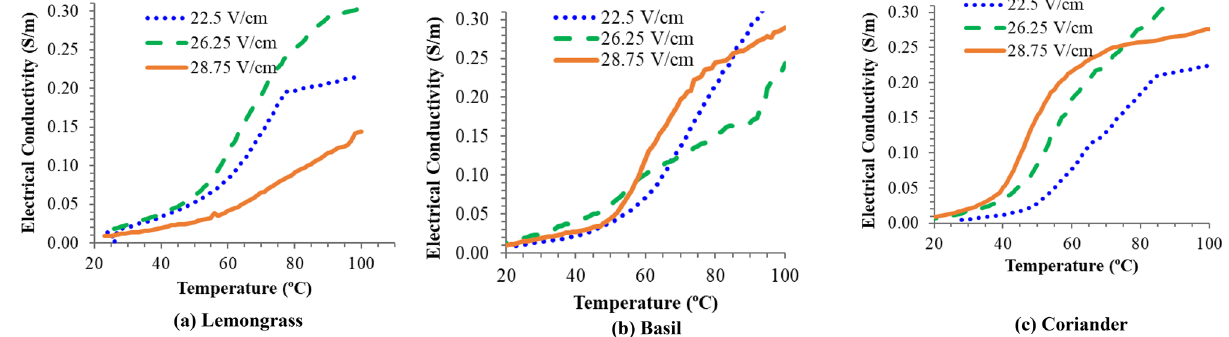
Figure 2. Graphical presentation of electrical conductivity × temperature relationship for: ( a ) Lemongrass, ( b ) basil, and ( c ) coriander leaves.